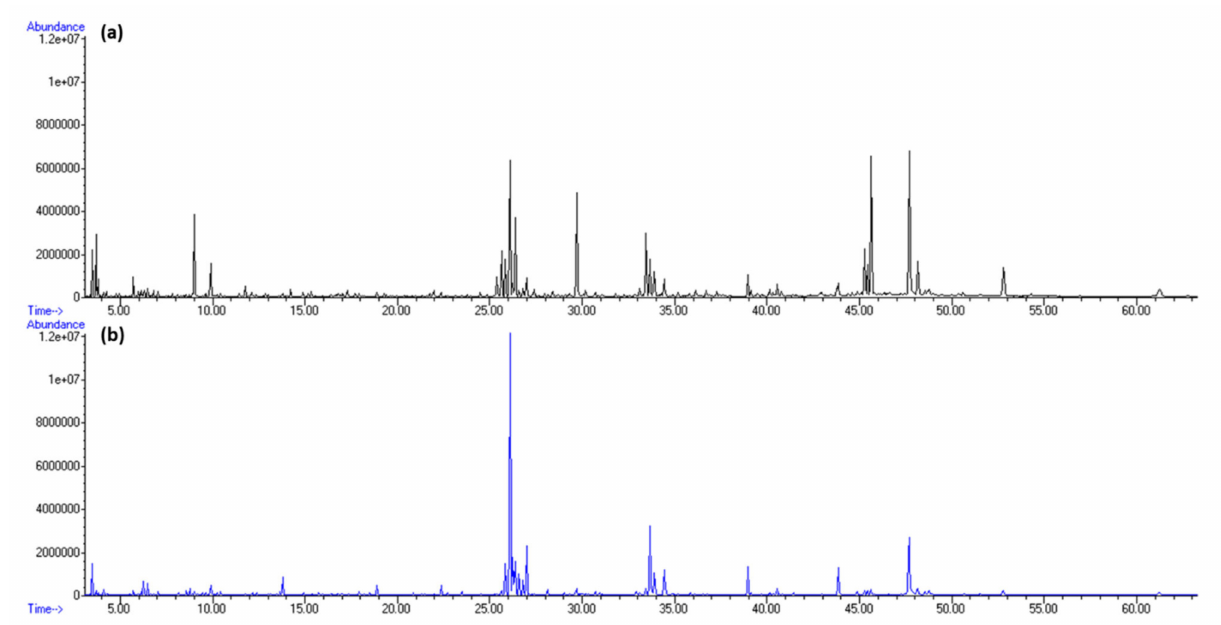
Figure 8. Total ion chromatogram (TIC) comparison of H. scoparia obtained by hydrodistillation (HD) and analysed by gas chromatography–mass spectrometry (GC–MS): ( a ) in May; ( b ) in